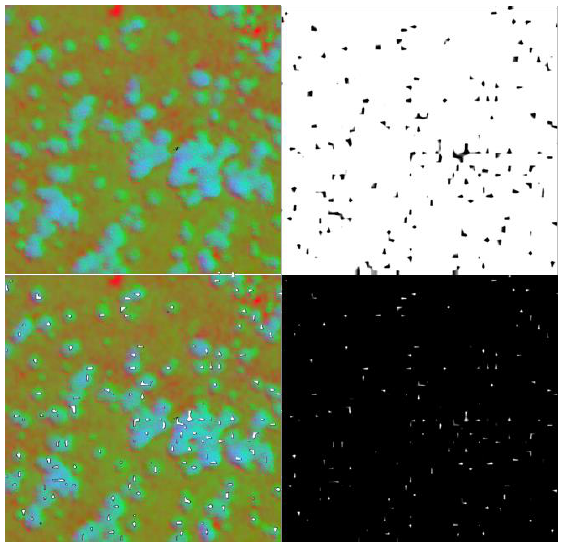
Figure 6. The treetop detection with FCN output. The top-left image is the input fused image with arbitrary size. The left- bottom image is the segmentation result (white for the treetops) overlapping the input image. Right images are the two output channels that represent the possibility of been non- treetops (right-top) and treetops (right-bottom). And the brighter the pixel, the higher possibility it belongs to the current category.